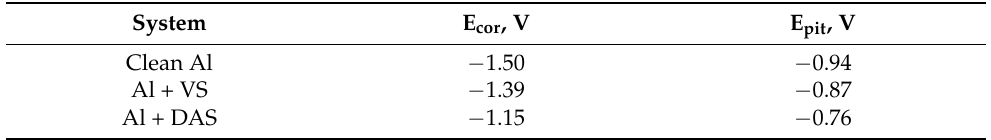
Table 1. E cor and E pit clean and modified aluminium in organosilane solutions, in buffered chloride- containing